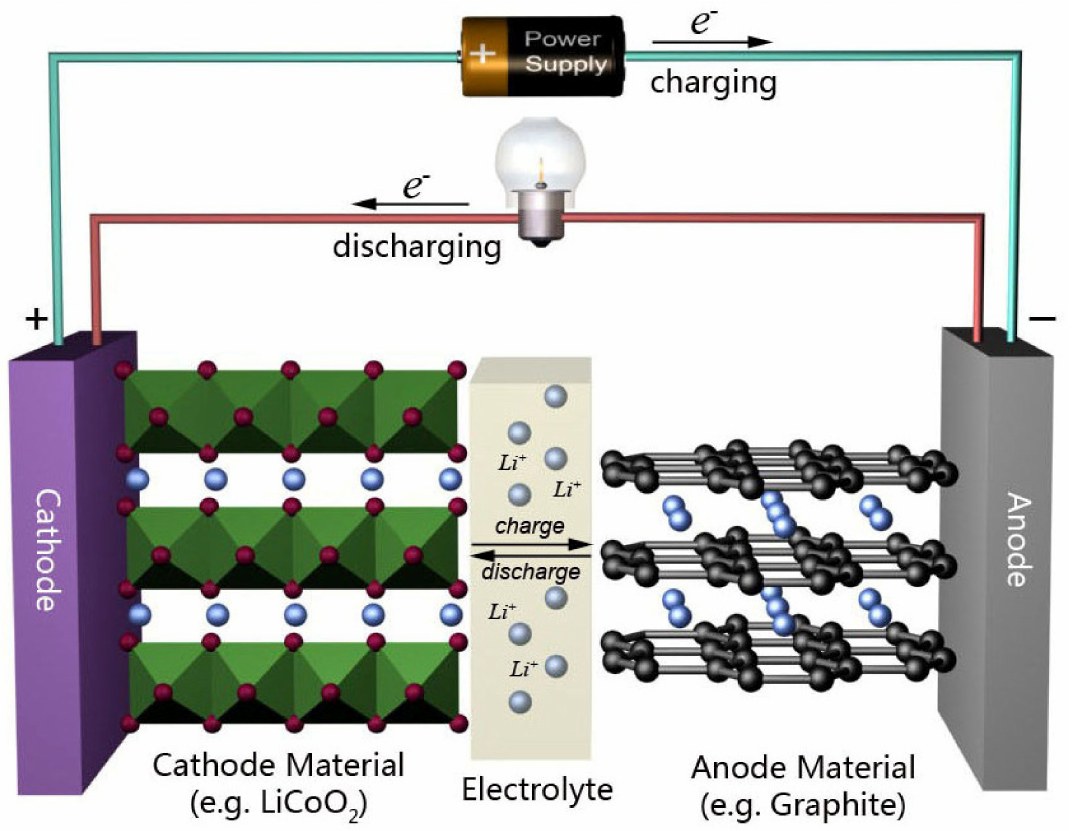
Figure 5. The charge/discharge intercalation mechanism of Li-ion battery. (Reproduced with permis- sion from ref